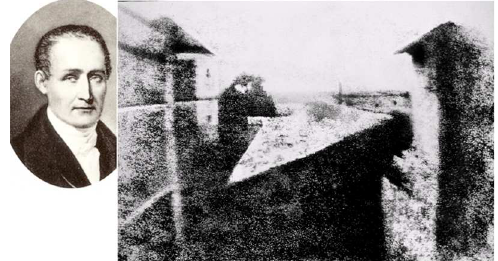
Figure 12. Color anaglyphs of the famous bust of Nofretete from Tell el-Amarna (Egypt) (nowadays in Berlin, Germany) showing extreme high resolution, in comparison with a “zero generation” lasered crystal of the same object, currently lacking resolution and radiometric significance.